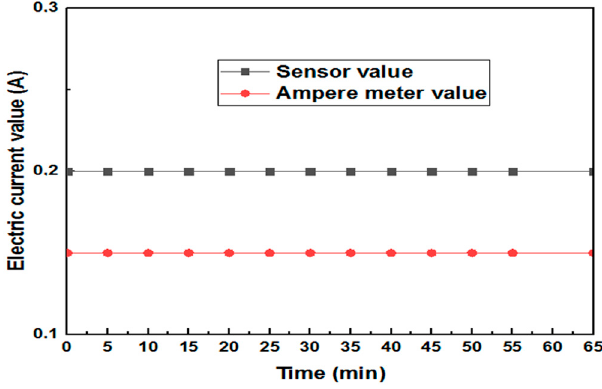
Figure 12. The outcome of measuring the load on light bulbs.